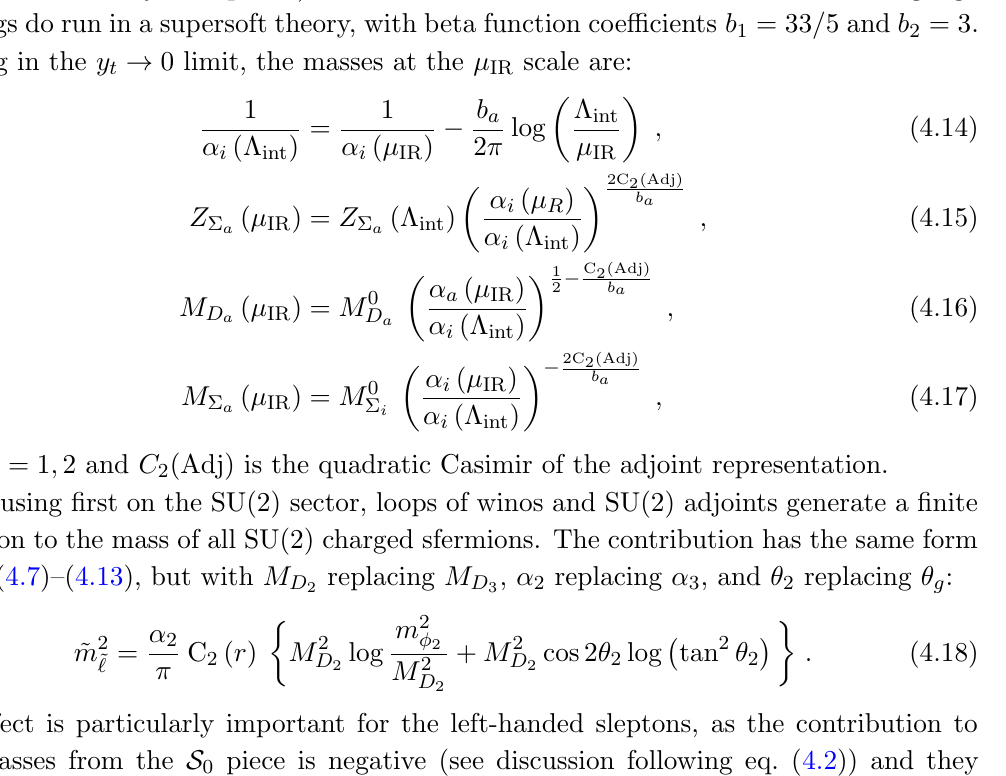
Figure 5 . Left: (cid:12)nite correction to the squark mass ~ m Dirac mass M 0 and adjoint Majorana mass M 0 D 3 gluino sector as a function of the same UV inputs. For both plots, we used the tree level relation m (cid:30) = 2 M D for simplicity and took (cid:22) IR = 10 3 GeV, (cid:3) int = 10 11 GeV and (cid:11) 3 ( (cid:22) IR ) = (cid:11) 3 ((cid:3) int ) 3 3